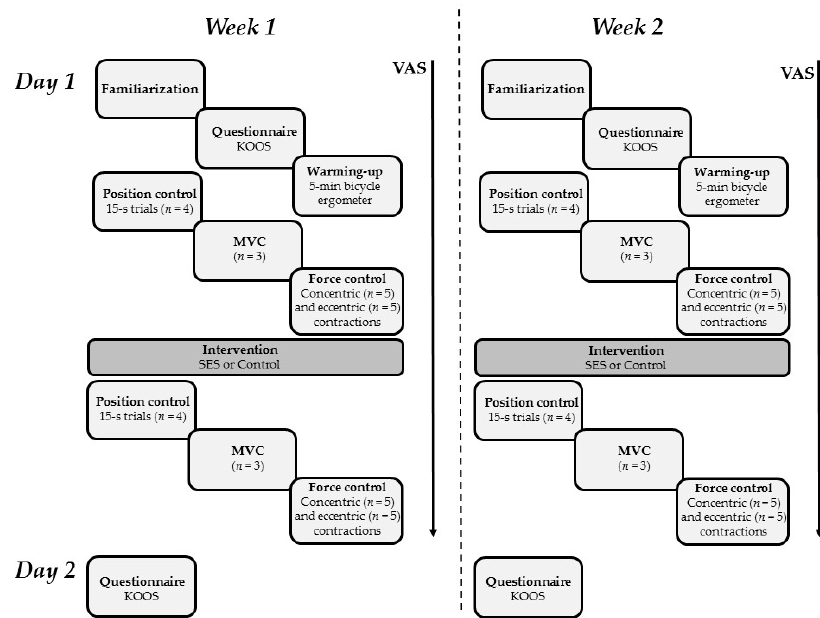
Figure 1. Schematic overview of the experimental protocol. The “ n ” within the boxes refer to the number of trials for that particular measure. KOOS: knee injury and osteoarthritis outcome score; MVC: maximum voluntary contraction; SES: somatosensory electrical stimulation. VAS: visual analogue scale.